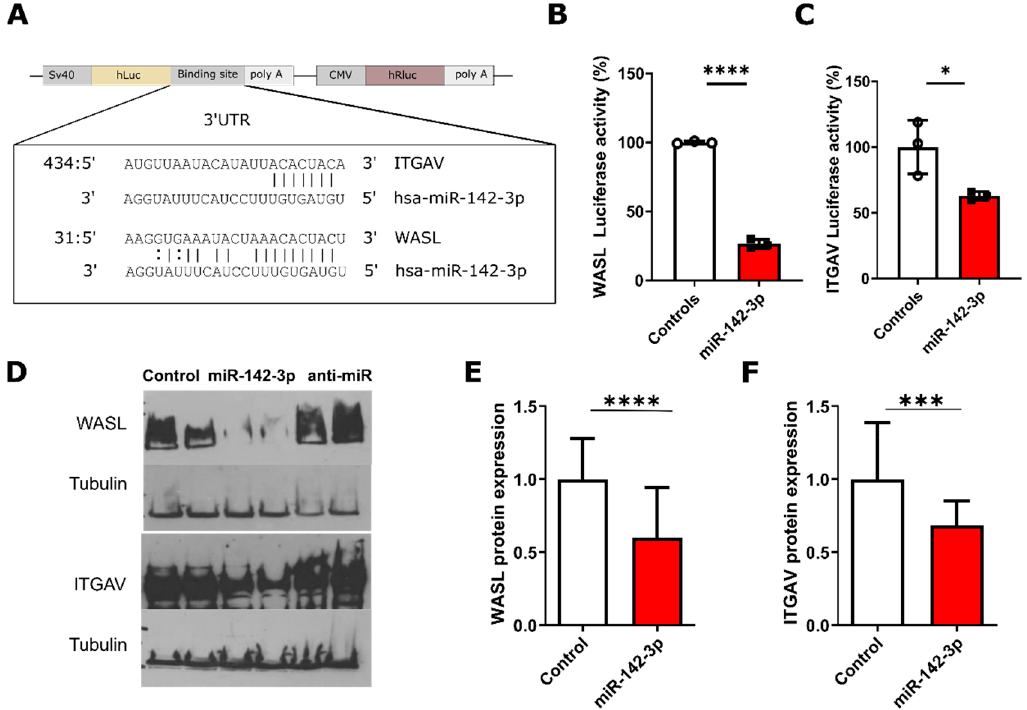
Figure 2. miR-142-3p inhibits WASL and ITGAV protein expression at the post-transcriptional level. ( A ) Luciferase 3 ′ UTR reporter vectors were used to assess hsa-miR-142-3p binding to the 3 ′ UTR of ITGAV and WASL mRNA. The insert shows complementary miR-142-34p targeting regions of the 3 ′ UTRs of ITGAV and WASL derived from the microRNA.org database. ( B ) miR-142-3p significantly ( p < 0.0001, n = 3, t -test) inhibits WASL -dependent luciferase activity. ( C ) miR-142-3p inhibits ITGAV - dependent luciferase activity ( p = 0.0359 n = 3, t -test). ( D ) Western blot analysis shows that miR-142- 3p reduces WASL and ITGAV protein levels in St-T1b cells, while anti-miR has no clear effect. ( E ) miR-142-3p reduces the level of WASL protein expression in primary ectopic ESCs ( p < 0.0001, n = 24, t -test). ( F ) miR-142-3p reduces the level of ITGAV protein expression in primary ectopic ESCs ( p = 0.0019, n = 19, t -test). Data in the figure panel represent mean ± s.d or mean + s.d. For all figures in this panel * p < 0.05; *** p < 0.001, **** p < 0.0001 and n.s. p >